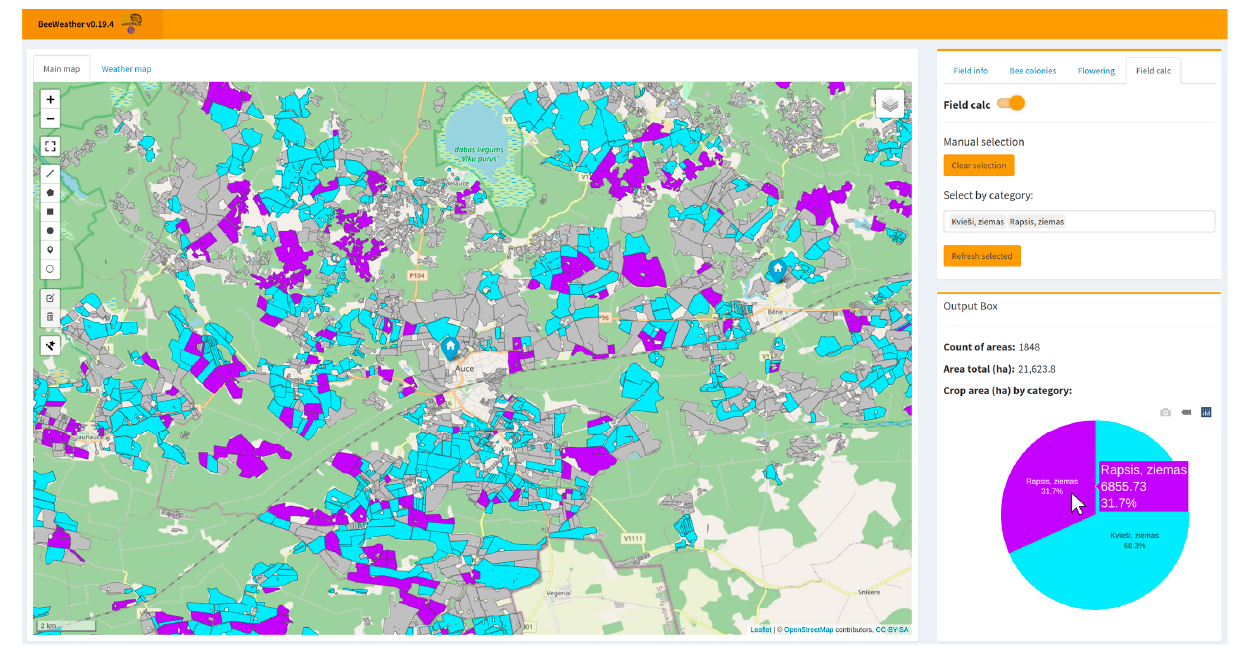
Figure 2. Selection by individual crop on the map.